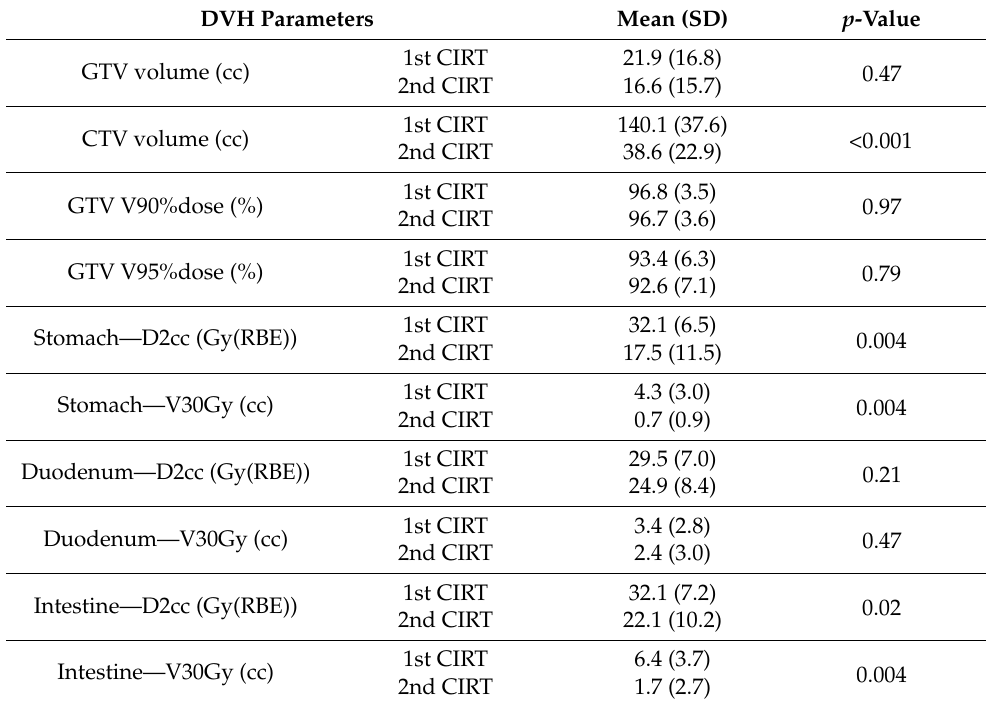
Table 4. Comparison of the DVH parameters between 1st and 2nd